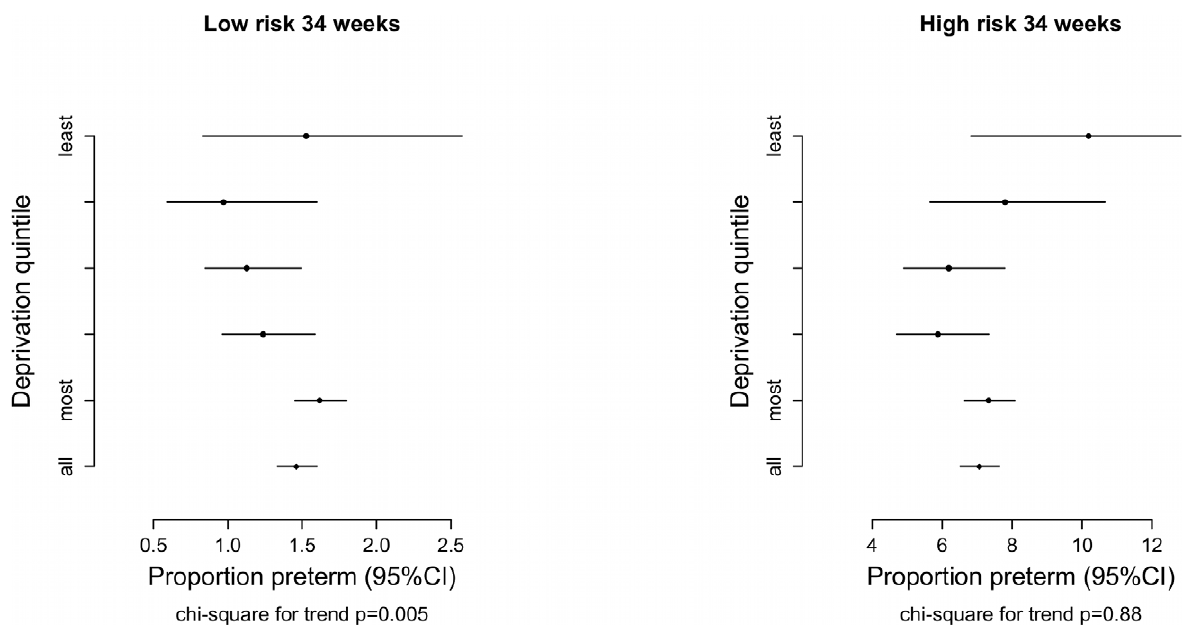
Figure 2. Proportion of PTB in low and high risk groups stratified by deprivation quintile.